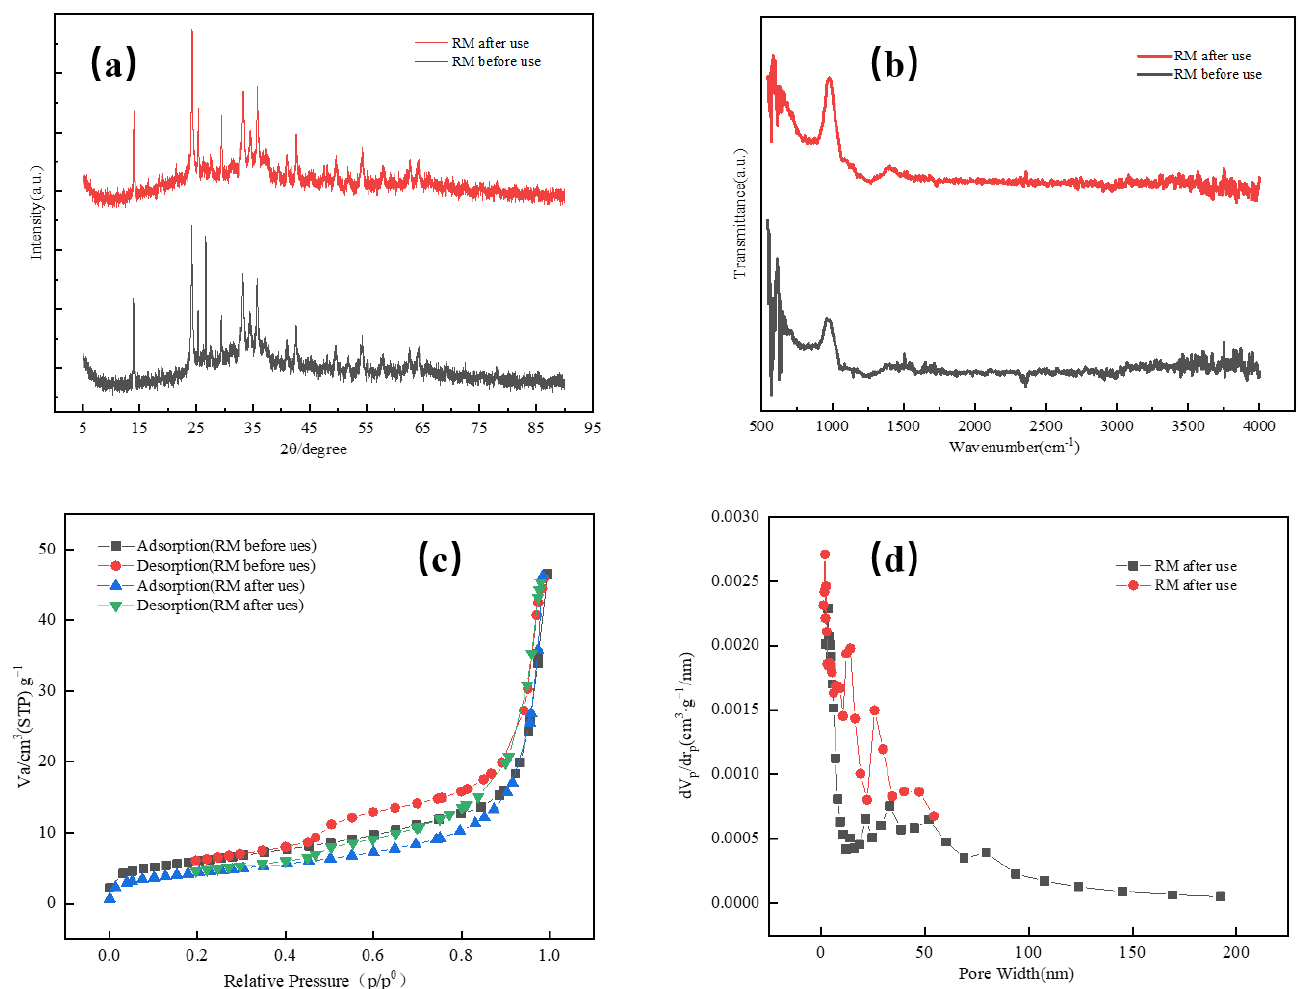
Figure 11. Red mud characterization: (a ) XRD, ( b ) FT-IR, ( c ) N 2 adsorption/desorption isotherms, ( d ) pore size distributions. Table 2. BET data of the red mud before and after use in the combined system. BET Surface Area Hole Wall Area Sample (m 2 /g) (m 2 /g) Red mud before use Red mud after